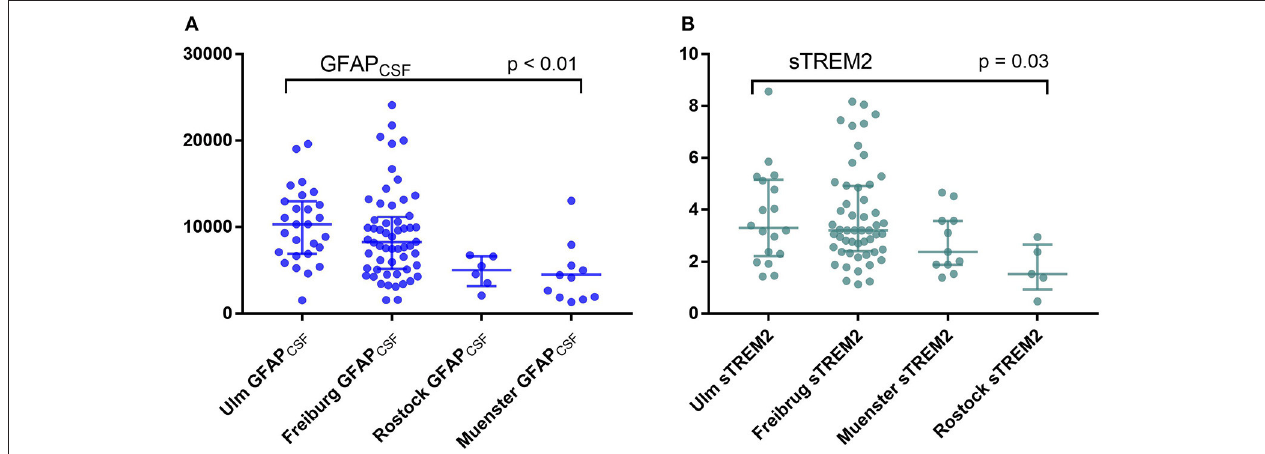
FIGURE 1 | Comparison between the levels of (A) glial fibrillary acidic protein (GFAP) and (B) soluble triggering receptor expressed on myeloid cells 2 (sTREM2) in cerebrospinal fluid (CSF) between the four participating centers (Kruskal-Wallis test).